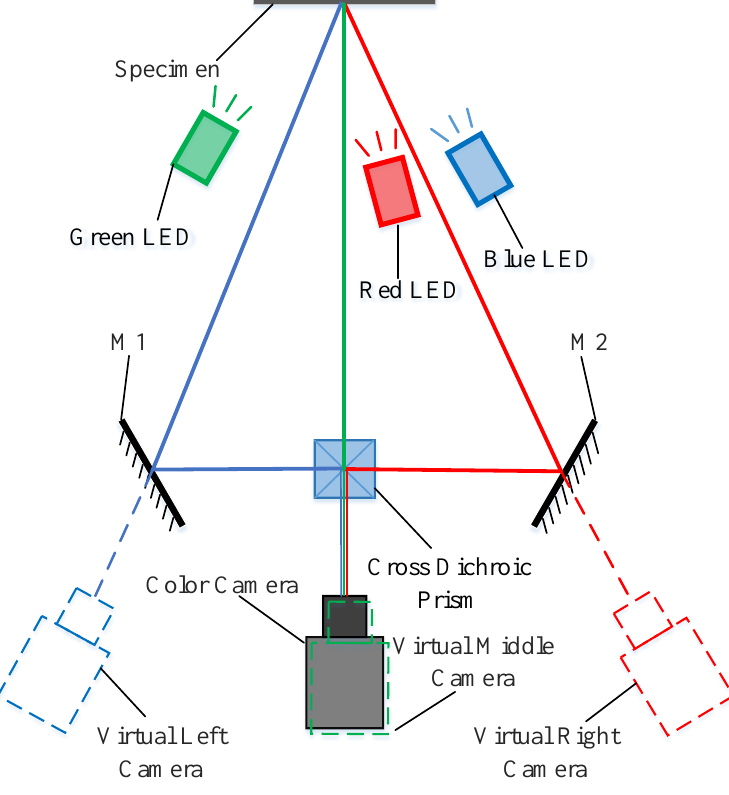
Figure 3. Scheme of the improved multi-perspective 3D-DIC system.